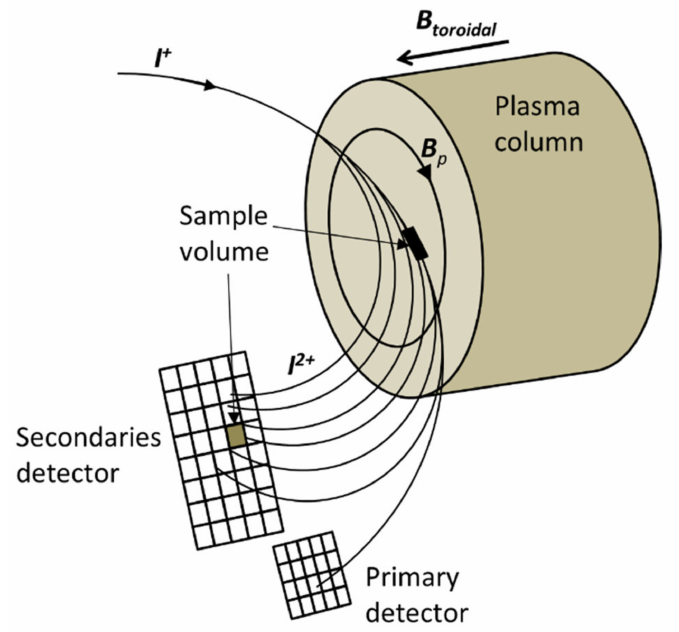
Figure 3. Schematic configuration of the heavy-ion beam diagnostic (HIBD). In this arrangement, all the secondary ions and the primary beam are detected in a multiple-cell array detector (MCAD).